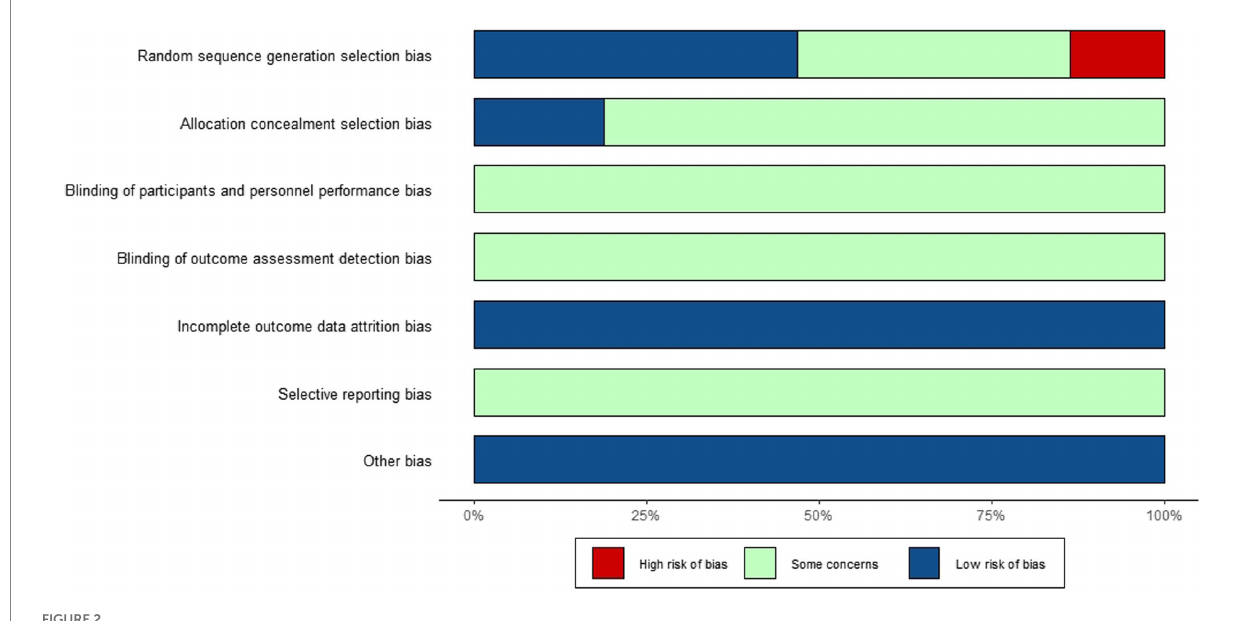
FIGURE 2 Risk of bias among included